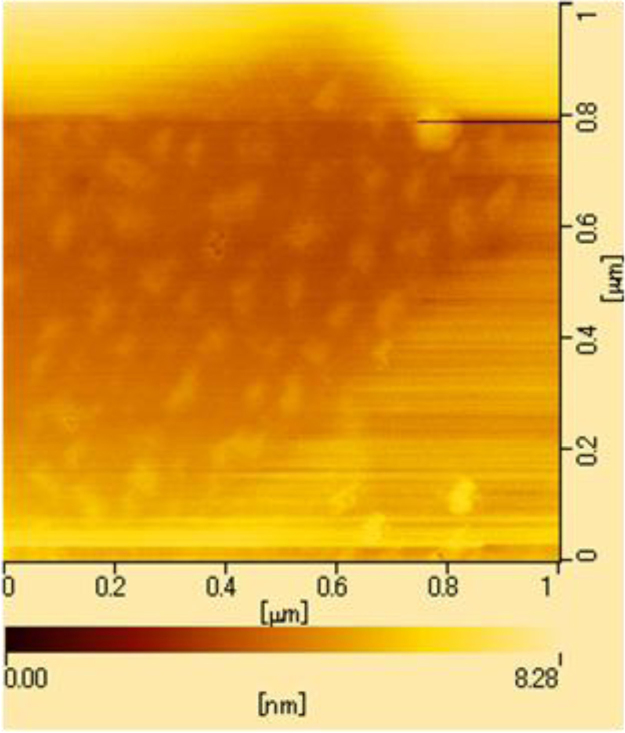
AFM image of the PAM-PDA18 micelles.